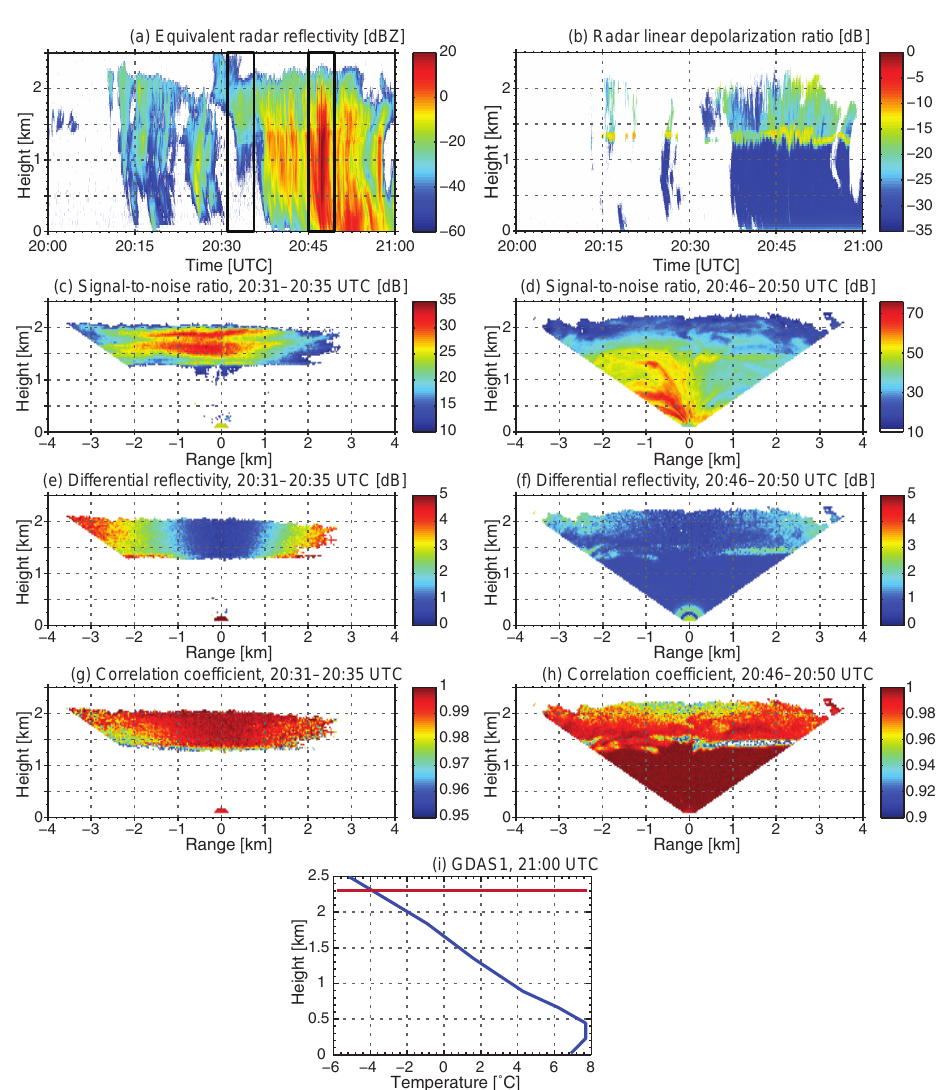
Figure 7. Case study of strong short-term variability of ice particle shapes observed at Cabauw, the Netherlands, on 7 November 2014. Shown are time–height cross sections of (a) equivalent radar reflectivity Z e from LDR-mode MIRA-35 and (b) radar linear depolarization ratio from LDR-mode MIRA-35; range–height cross sections of (c) signal-to-noise ratio, (e) differential reflectivity Z DR , and (g) correlation coefficient ρ HV measured by hybrid-mode MIRA-35 from 20:31 to 20:35UTC; (d) signal-to-noise ratio, (f) differential reflectivity Z DR , and (h) correlation coefficient ρ HV measured by hybrid MIRA-35 from 20:46 to 20:50UTC; (i) vertical temperature profile from the GDAS model. Two black rectangles in (a) show the analyzed cloud layer and the time periods corresponding to full elevation scans of hybrid-mode MIRA-35. Z e and LDR were calculated from total powers in the co- and cross-channels. SNR, Z DR , and ρ HV were obtained for the spectral peaks. Note that Z DR and ρ HV are not corrected for the antenna coupling here to make figures more illustrative. The red horizontal line in (i) represents the cloud top at